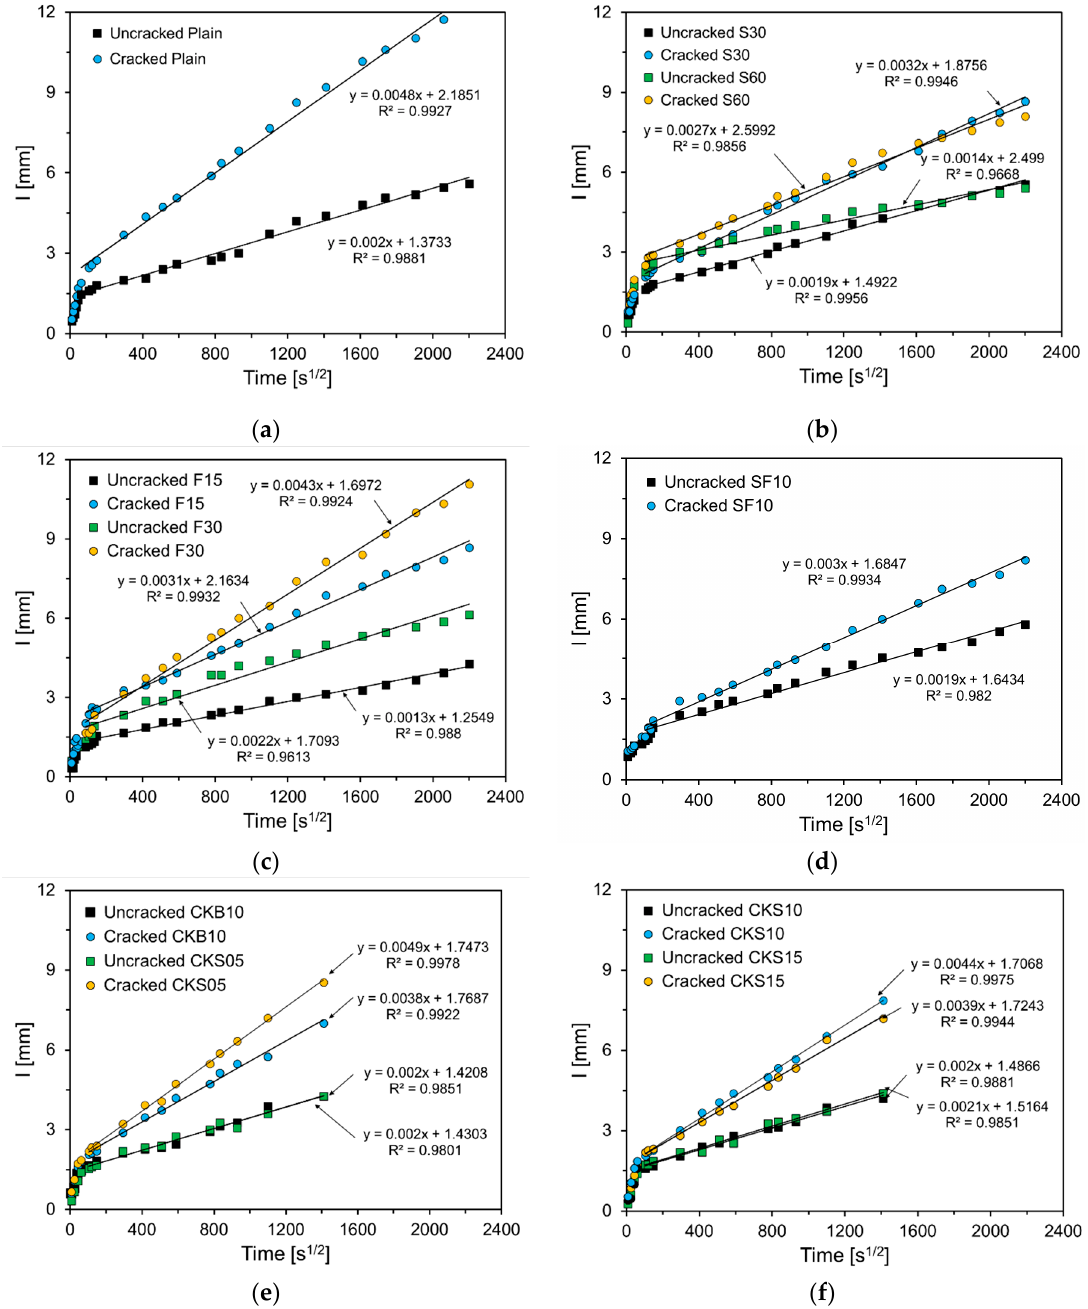
Figure 5. Water absorption test results: ( a ) Plain; ( b ) S30, S60; ( c ) F15, F30; ( d ) SF10; ( e ) CKB10, CKS05; ( f ) CKS10, CKS15.